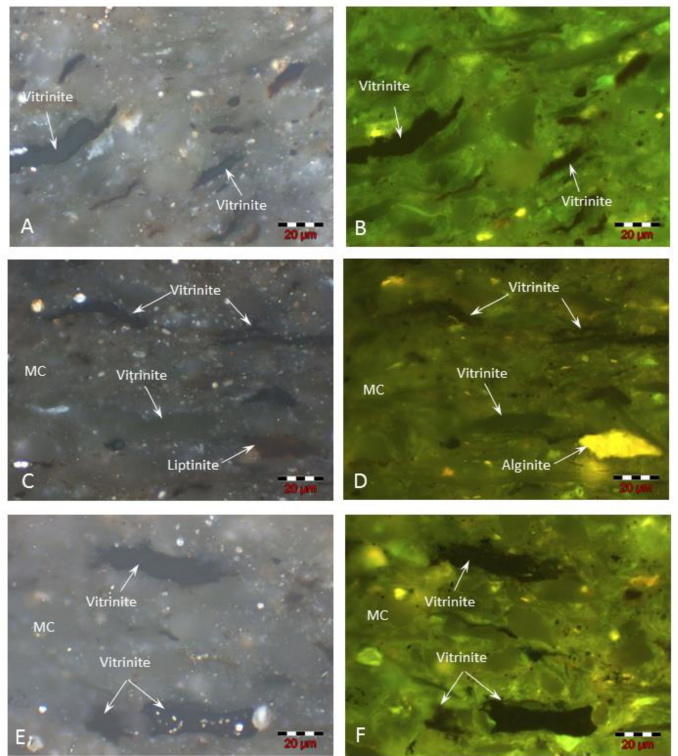
Figure 5. Photomicrographs of C-1 Socu Upper Badenian source rocks of the Getic Depression showing vitrinite associated with mixed, continental, and marine origins liptinite in a mineral groundmass with pyrite. Reflected light (RL: figures A , C , E ) and fluorescence (FL: figures B , D , F ), oil immersion, 500 × . Py: pyrite, MC: mineral carbonate.